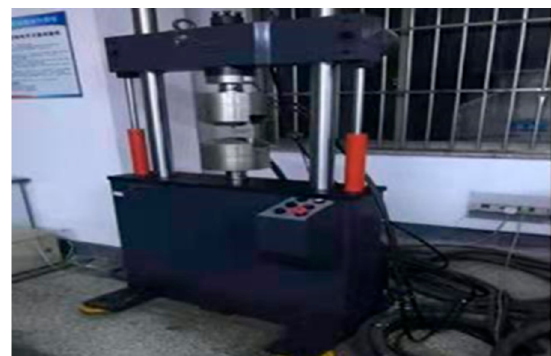
Figure 2. Test sample after fatigue.